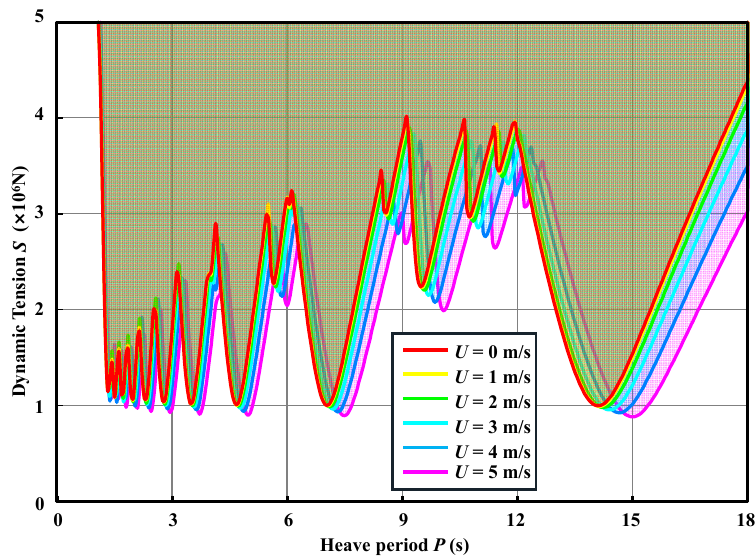
Figure 10. Parametric instability charts of risers with the different internal flow velocities.